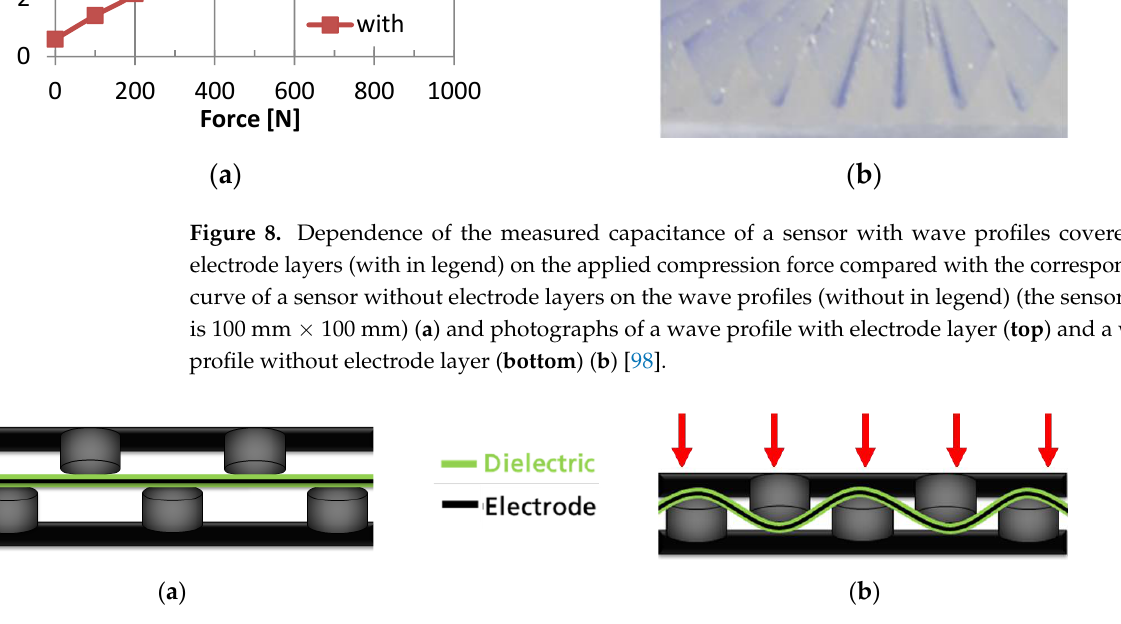
Figure 9. Scheme of a dielectric elastomer pressure sensor with two knot-shaped profiled outer films with electrode layers and an elastomer film with only one electrode layer covered by two dielectric layers between the profiles in the unloaded state ( a ) and in the loaded state ( b ) [99].